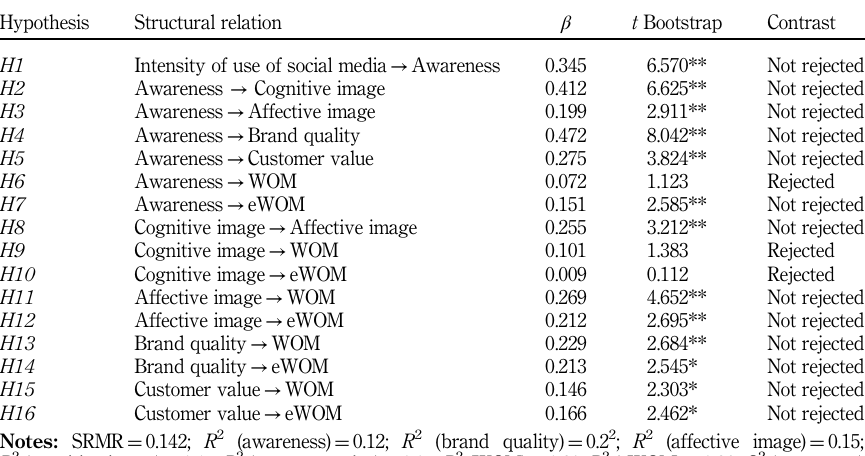
Table V. Contrast of the